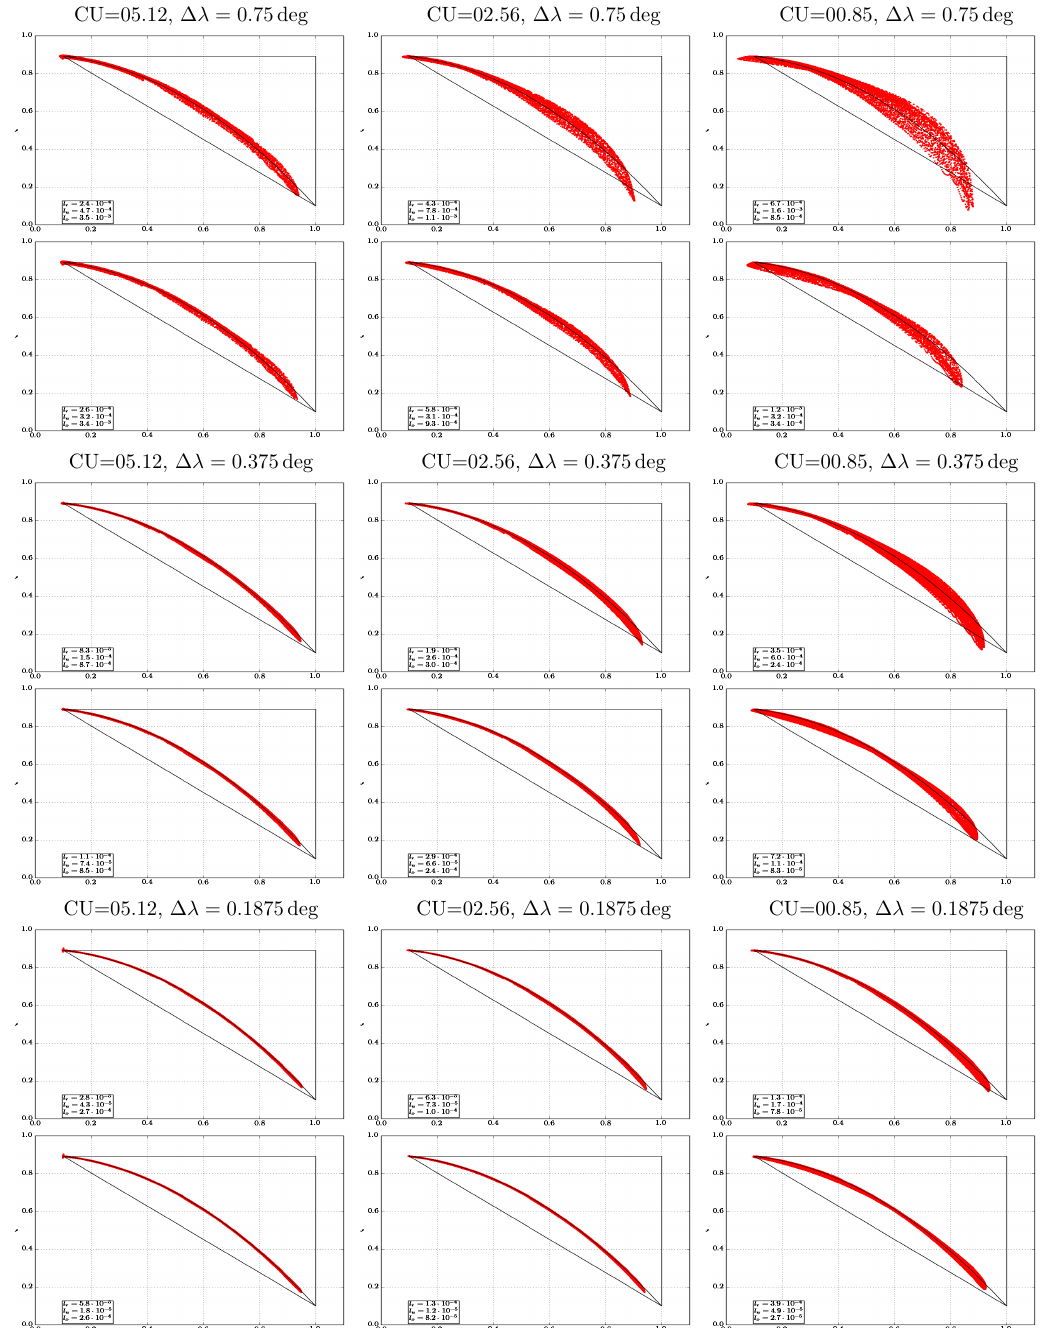
Figure 13. Mixing preservation test for cosine bells and correlated cosine bells Eq. (27) at t = T/ 2. Every two lines show the tests without (upper line) and with (lower line) a smoother